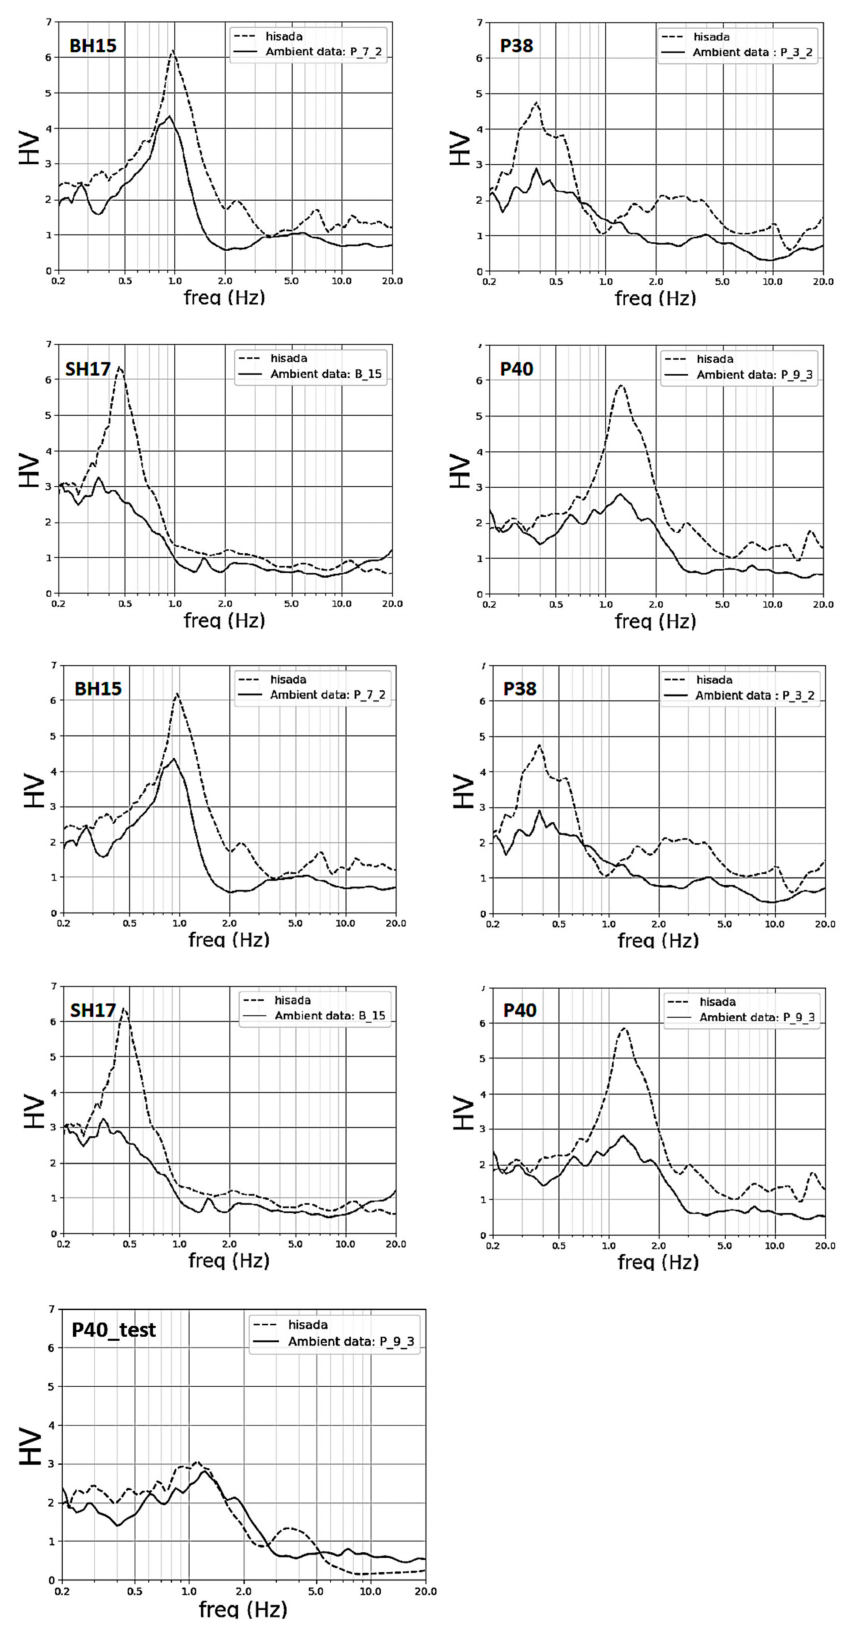
Figure 19. Synthetic (dashed line) versus observed (solid line) HVSRs for the eight selected sites on the West-East cross section of Figure